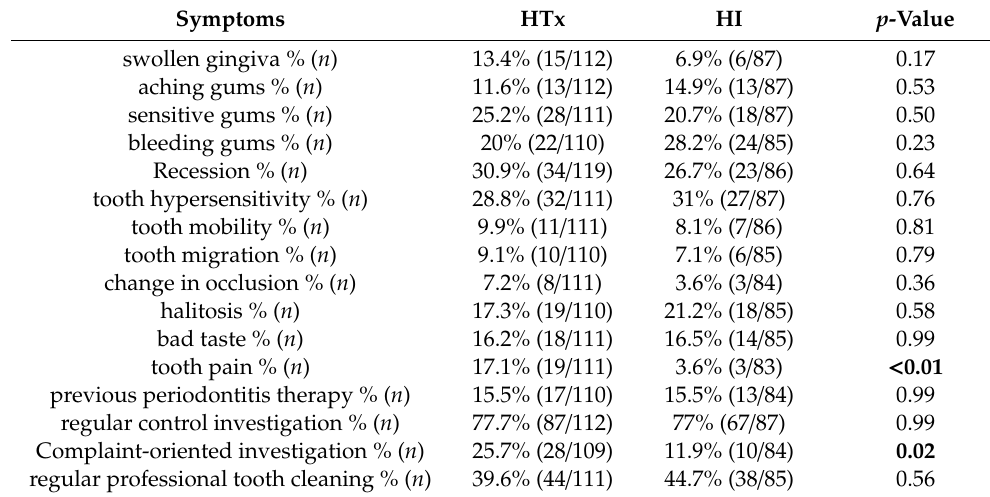
Table 3. Results of the periodontitis questionnaire, significance level: p <